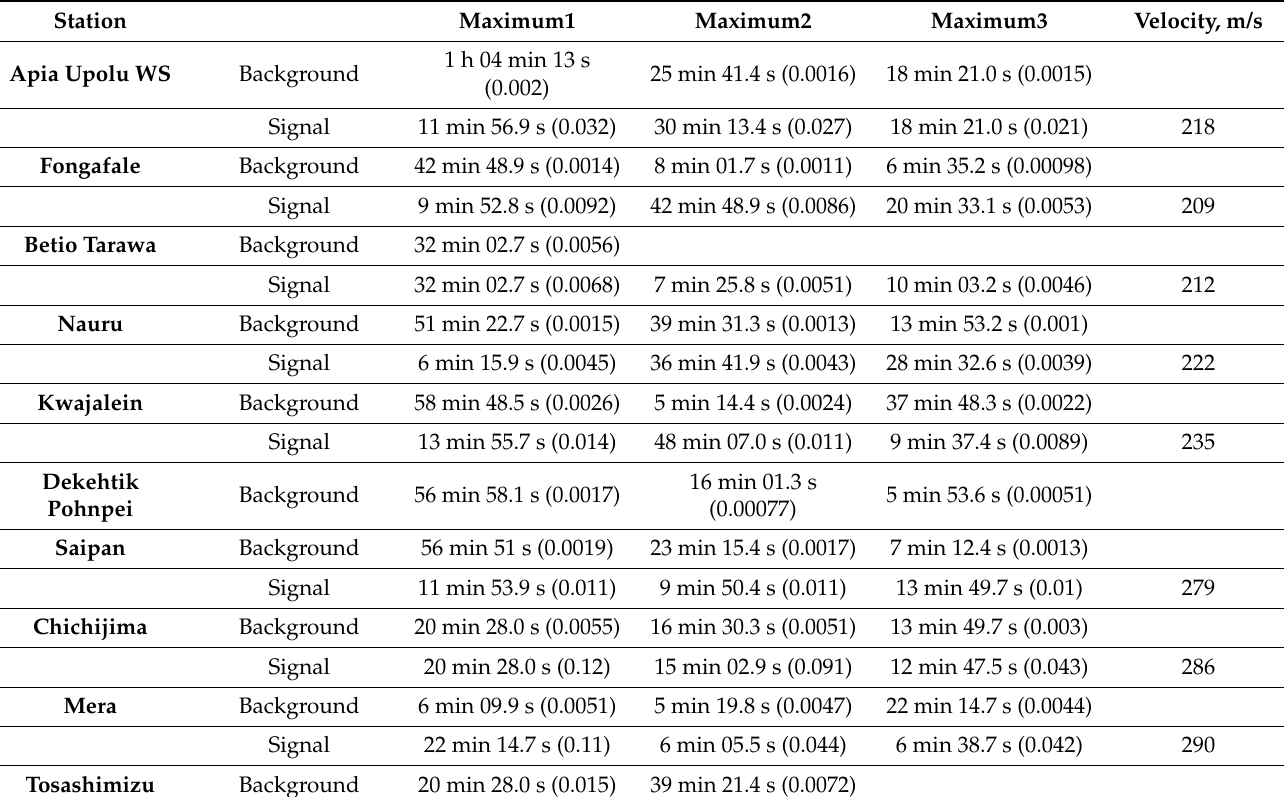
Table 4. Statistics of the results of background data and disturbance signal data